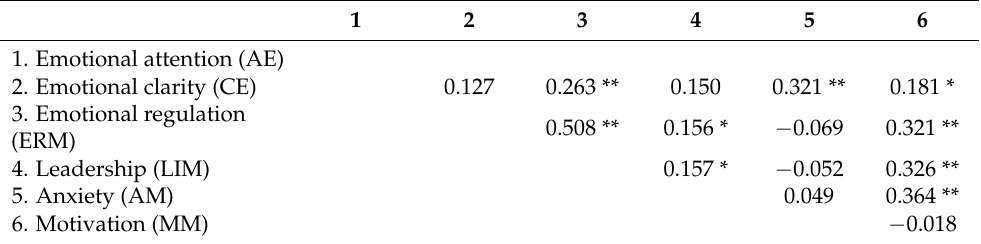
Table 1. Preliminary analysis.